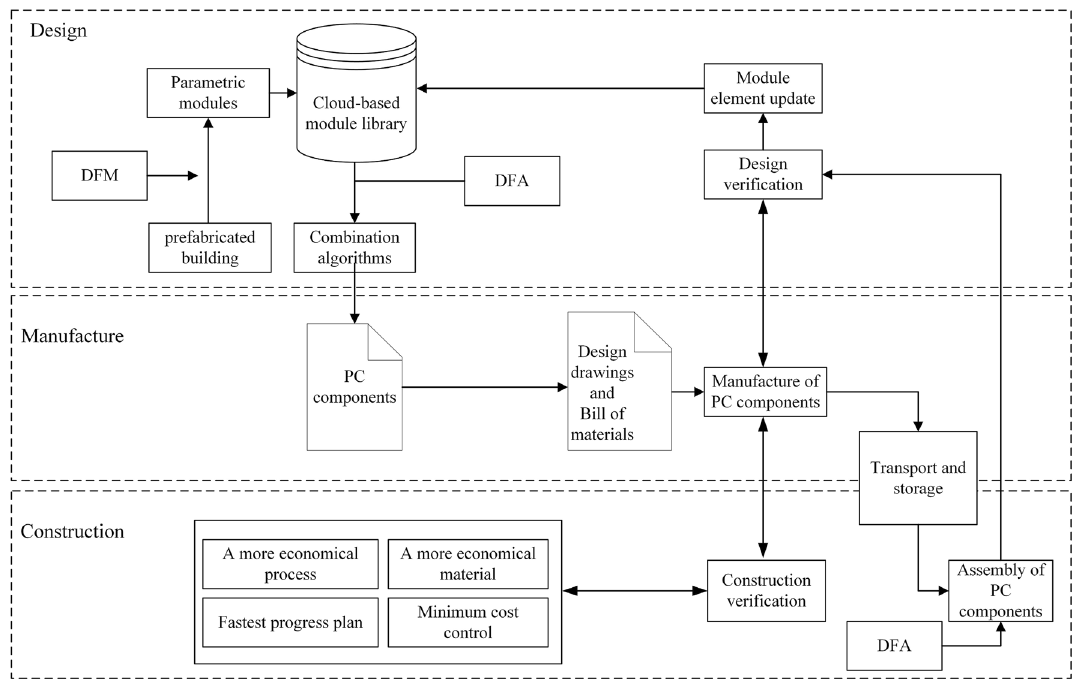
Figure 13. DFMA-oriented whole-life optimization process for assembled